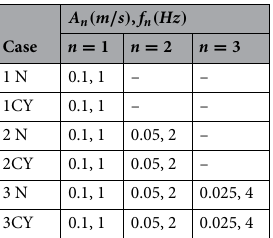
Table 1. Details of the boundary conditions of the six LES cases as represented by Eq. (8). N and CY stand for Newtonian and Carreau–Yasuda models. The steady velocity component was fixed at: u o = 0.175 m /